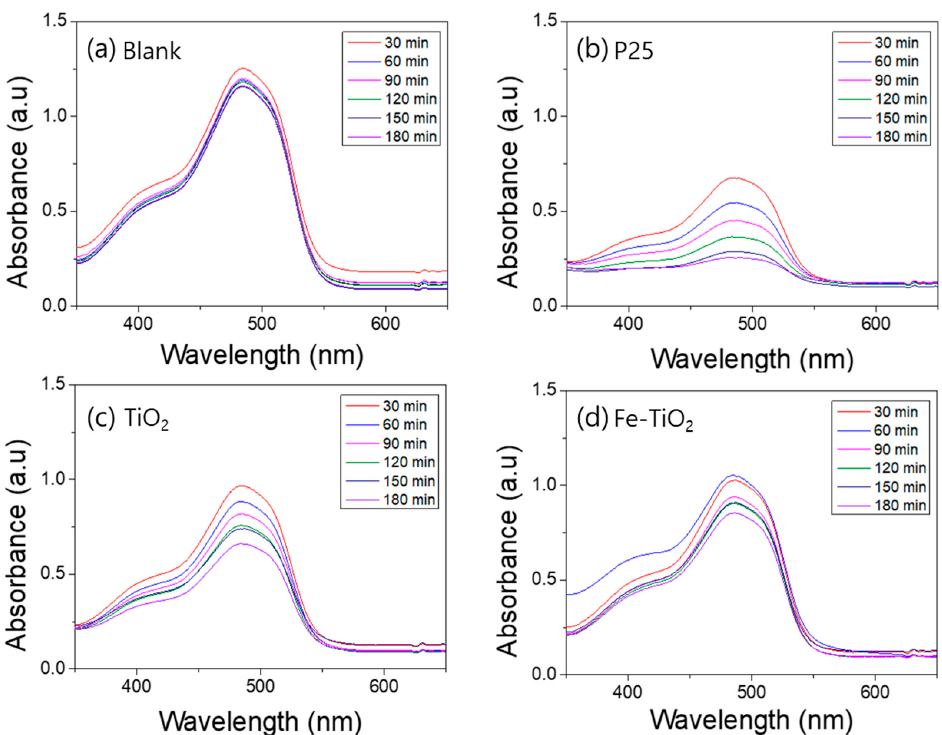
Figure 8. UV–Vis absorption spectra of the ultraviolet photocatalytic degradation of an aqueous methylene blue solution by nanofibers: ( a ) blank, ( b ) P25, ( c ) TiO 2 nanofibers, ( d ) Fe-doped TiO 2 nanofibers.